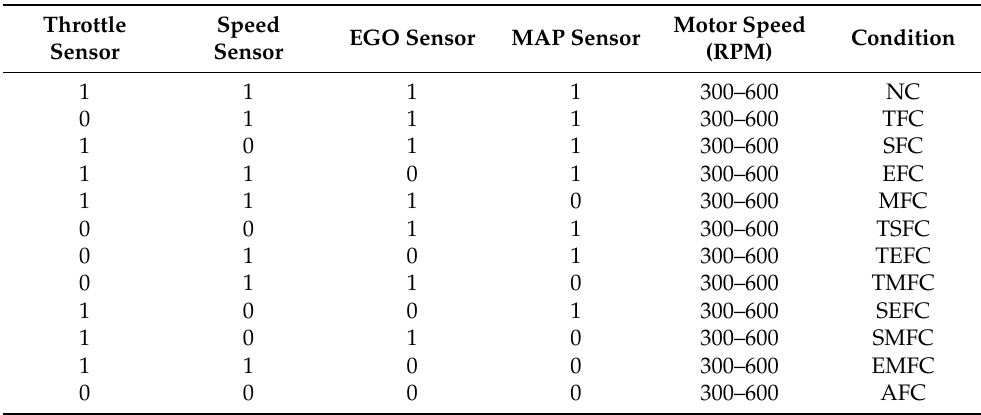
Figure 3. Air-to-fuel-ratio signal when sensors operate in normal and abnormal conditions.